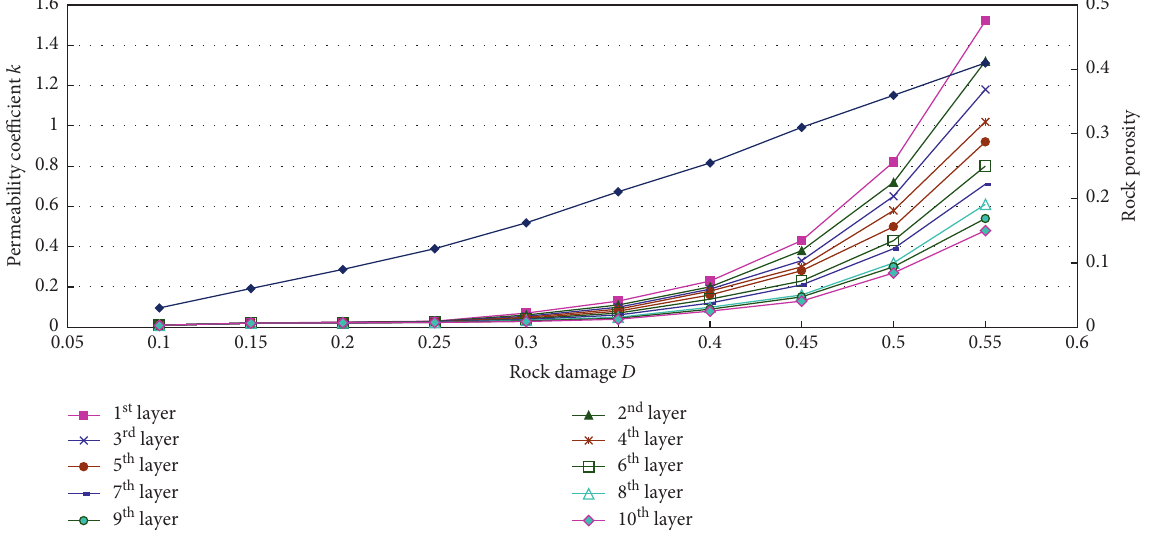
Figure 14: Evolution of the permeability coefficients of the 1 st –11 th rock